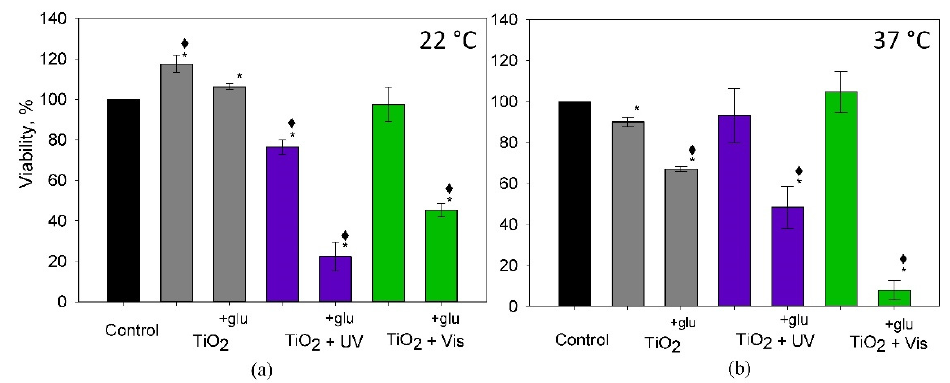
Figure 3. The impact of incubation medium temperature, ( a ) 22 ◦ C; ( b ) 37 ◦ C, on bactericidal properties of TiO 2 . Experiments were performed in PBS buffer, pH 7.4, without and with (+glu) the addition of 0.1% glucose. The initial concentrations of S. Typhimurium cells and TiO 2 photocatalyst were 3 × 10 7 cfu/mL and 0.3 mg/mL, respectively. * and ♦ mark experimental values which are significantly different from the control sample and other samples respectively (more details on statistical analysis are provided in Section 4.5).